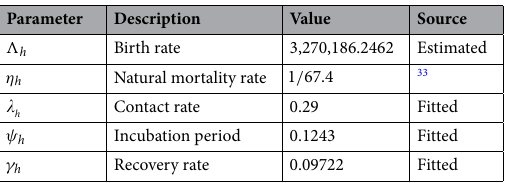
Table 1. Estimated and fitted values for different parameters of model